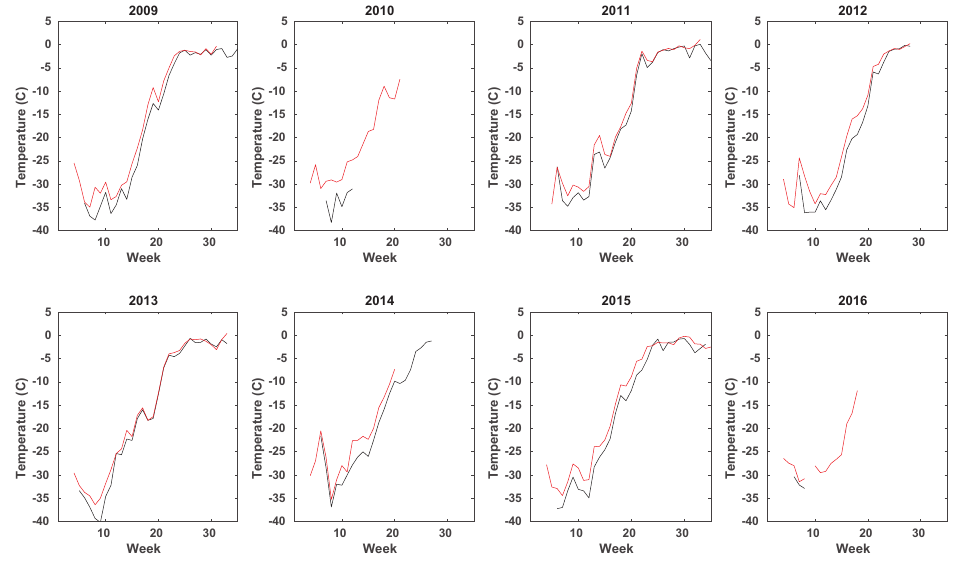
Figure 5. Ice Surface Temperature trends for melted ( red ) and surviving ( black ) parcels during